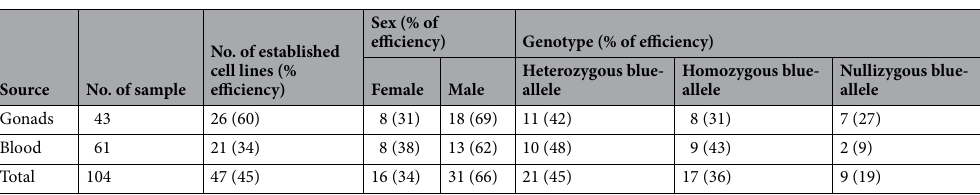
Table 1. Derivation and genotyping of PGCs from different